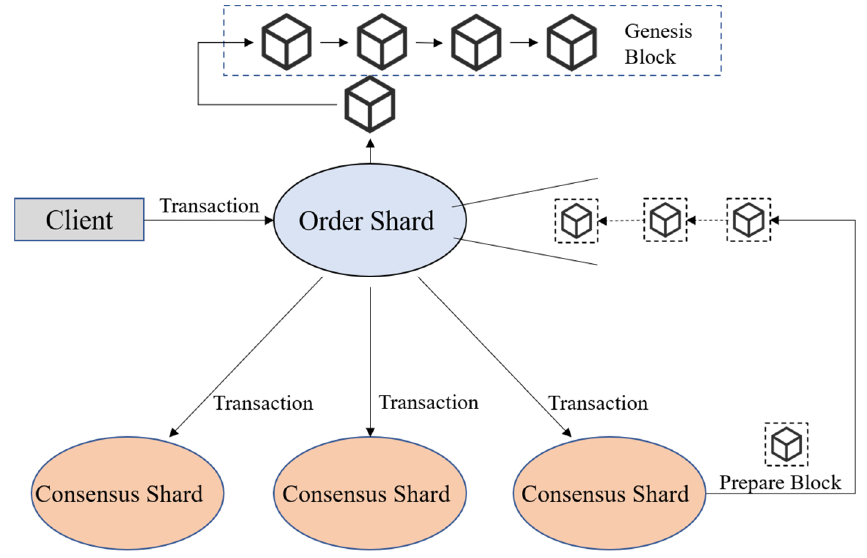
Figure 5. Relationship between shards.